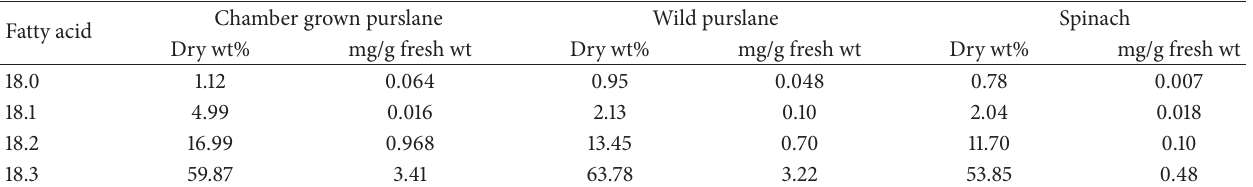
Table 4: Fatty acid profiles in total lipid extracts from leaves of purslane and spinach.